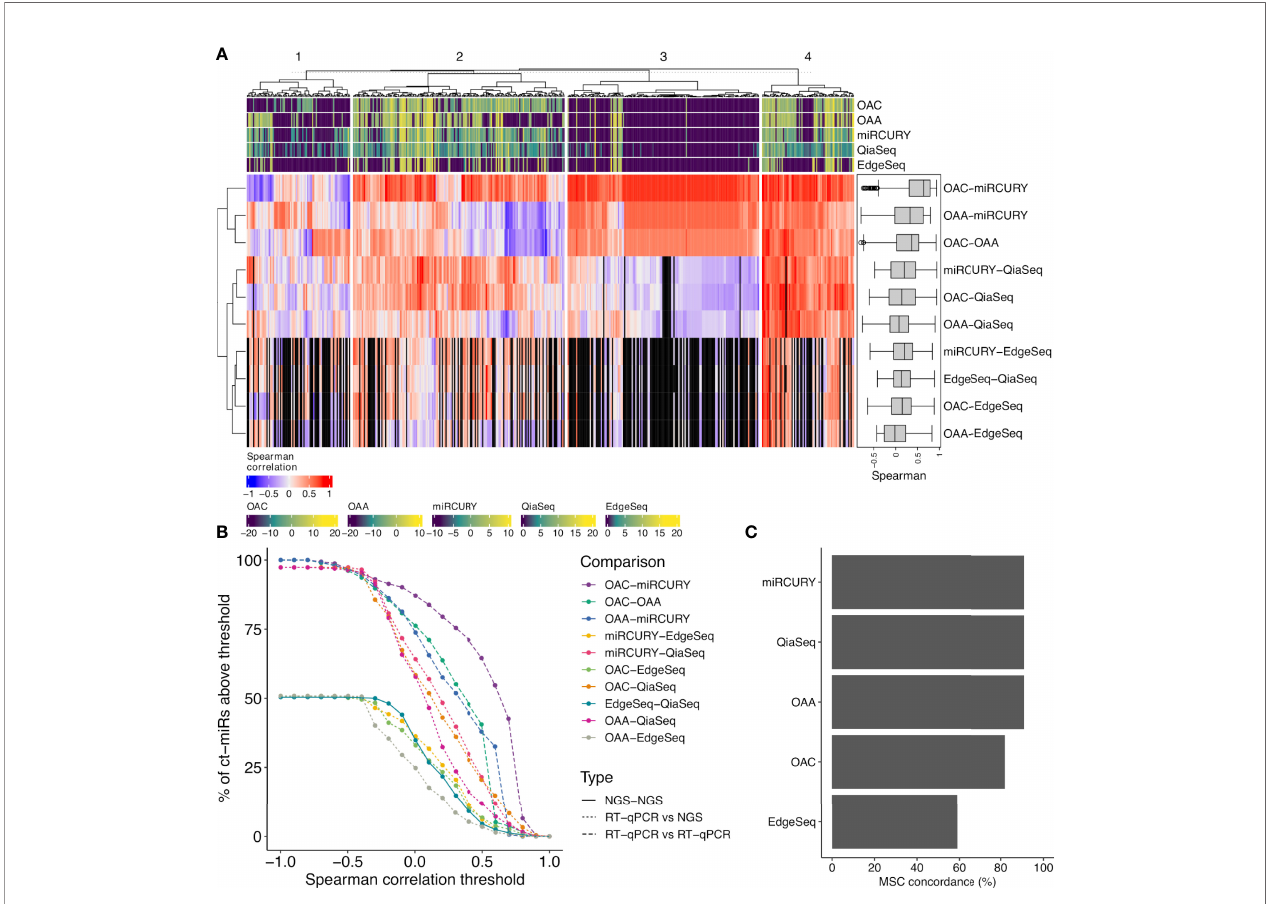
FIGURE 3 | Correlation analysis between each pair of platform and concordance assessment for the miR signature classi fi er (MSC). (A) The correlation heat map shows how the different platforms correlate with respect to the expression values of the 488 common miRs. The median pairwise Spearman ’ s correlation values are shown also as boxplots in a black box (right corner). The colored bars on the top and bottom of the heat map (violet- to yellow-colored gradient) de fi ne the median- normalized expression values of each platform. Four functional groups are identi fi ed and de fi ned according to different levels of correlation (1, scarce; 2, intermediate; 3, both positive (red) and negative correlation (blue); 4, high). The black vertical bars represent the miRs with an expression value of 0 in EdgeSeq platform that do not correlate. (B) Curves showing the number of ct-miRs correlated above increasing correlation cutoffs for each pairwise comparison between platforms. (C) Bar plots displaying the percentage of concordance in assigning the label miR risk classi fi er MSC — high or MSC — low compared with the reference platform (Custom- made Micro fl uidic Cards, Thermo Fisher) used to calculate the clinical validated